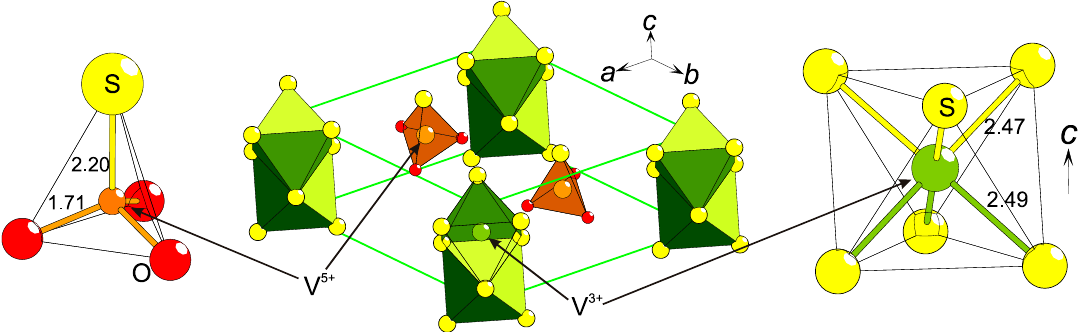
Figure 4. The polar [VSO 3 ] 3 ´ unit ( left ) imposes an indirect electric polarization on the quasi-1-D [VS 6/2 ] 3 ´ chain in Ba 3 V 2 S 4 O 3 ( center ). This causes a shift of V 3+ within the chain ( right ). All distances are in Å and Ba 2+ ions were left out for simplification.